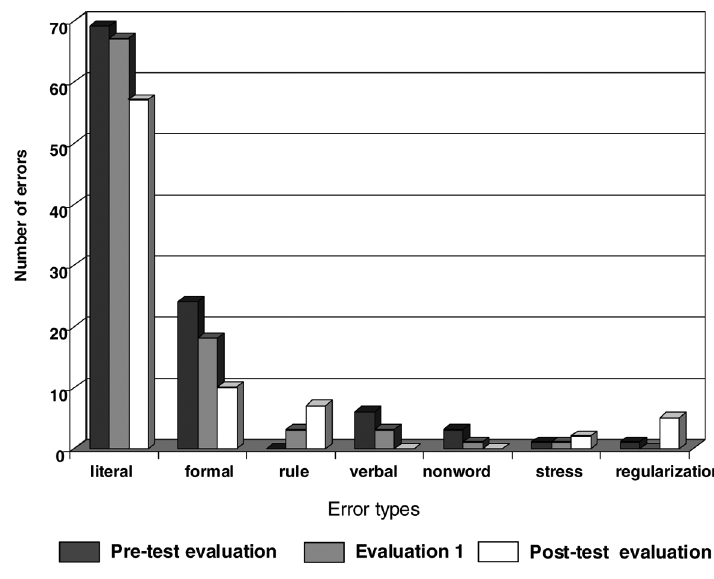
Figure 3. Types of errors of OCS on the HFSP oral reading